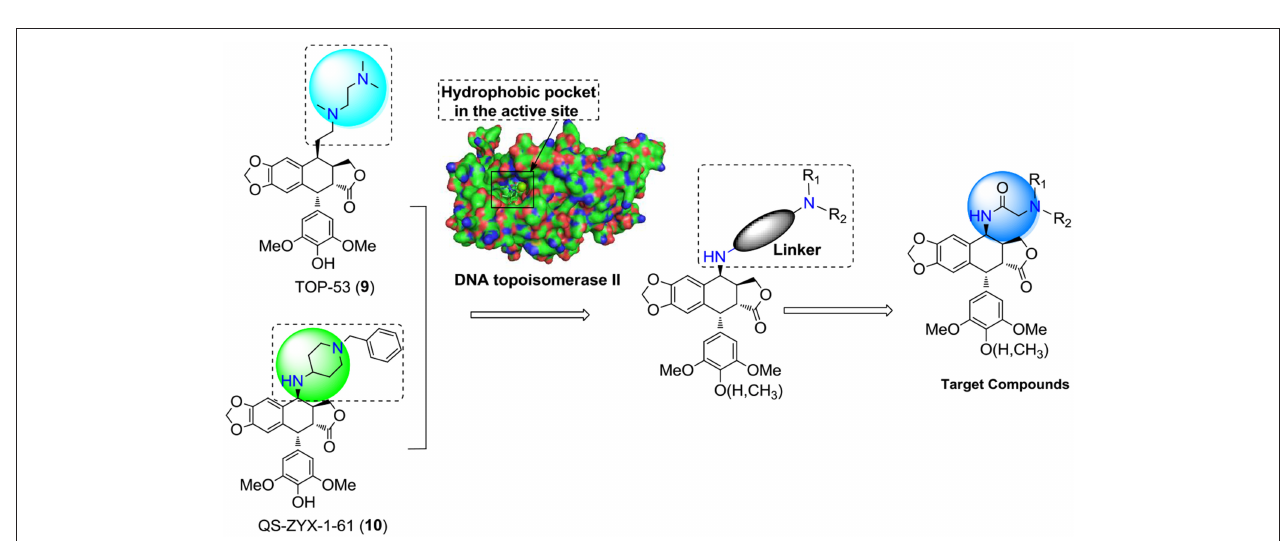
FIGURE 2 | Rational design of the target